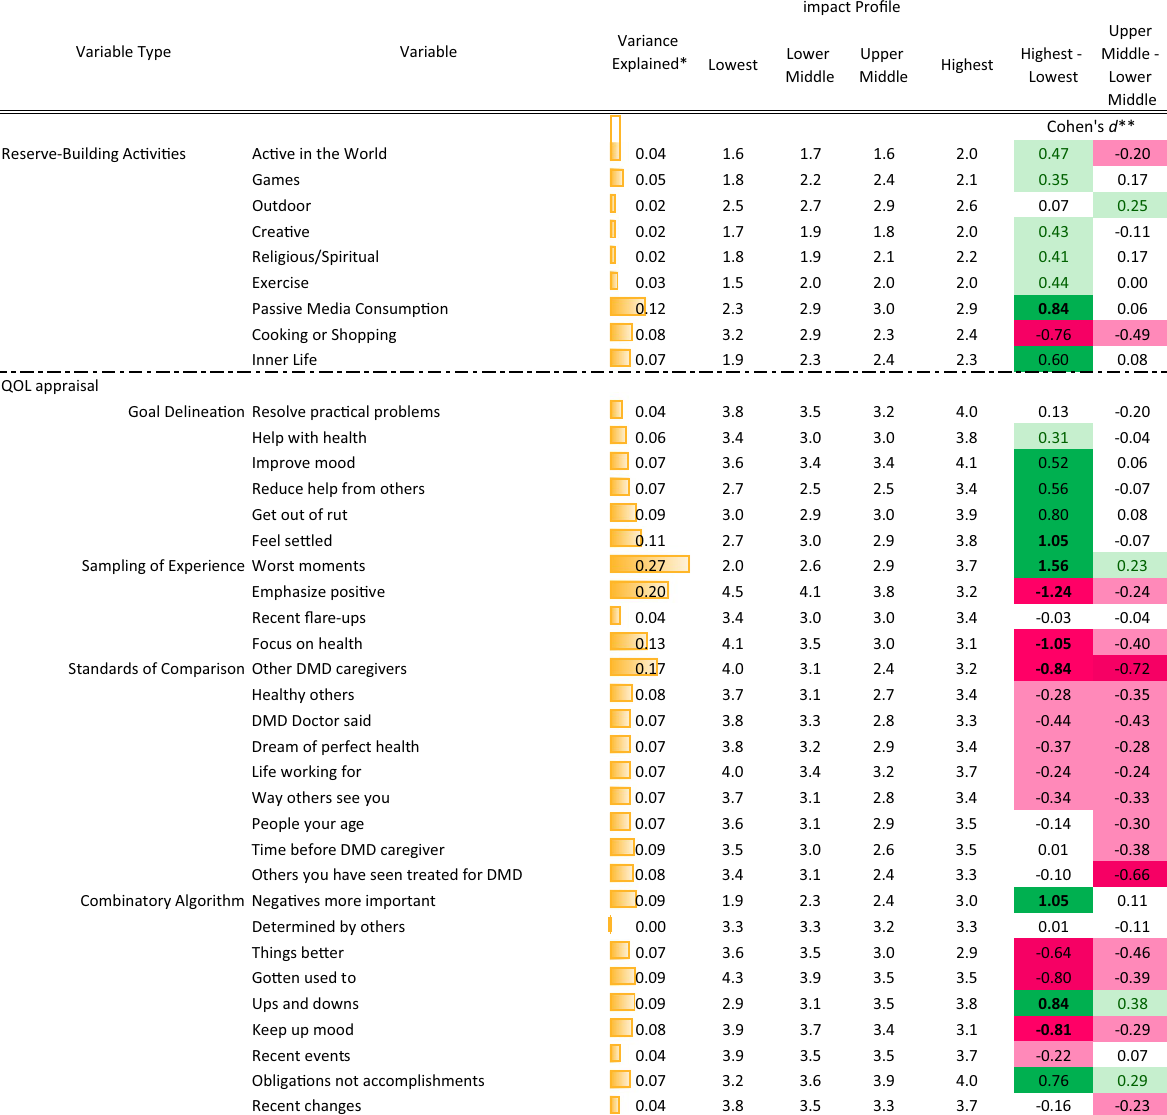
Upper Lower Upper Highest - Middle - Lowest Highest Middle Middle Lowest Lower Middle